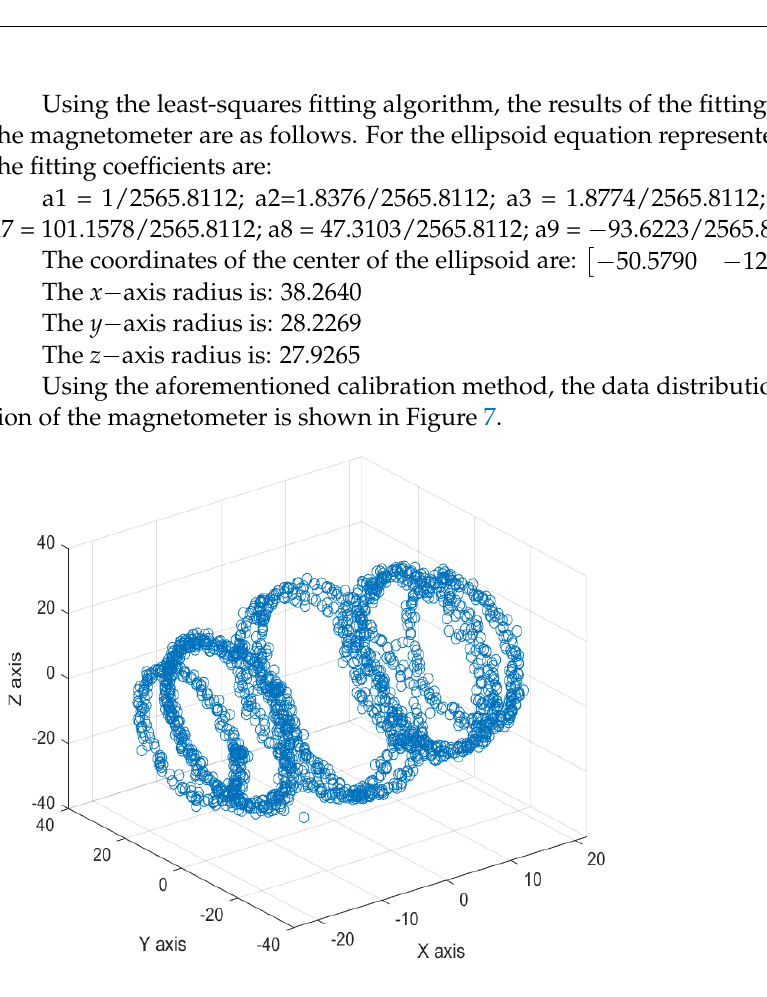
Figure 7. Spatial distribution of data after calibration.